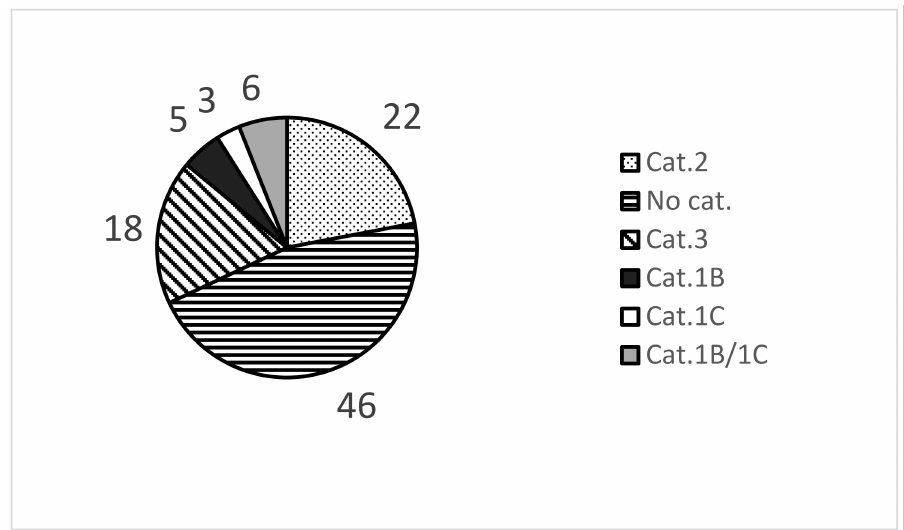
Figure 2. Composition of 100 reference chemicals in ChemSkin DB Pie chart of 100 chemicals classified by in the in vivo category.